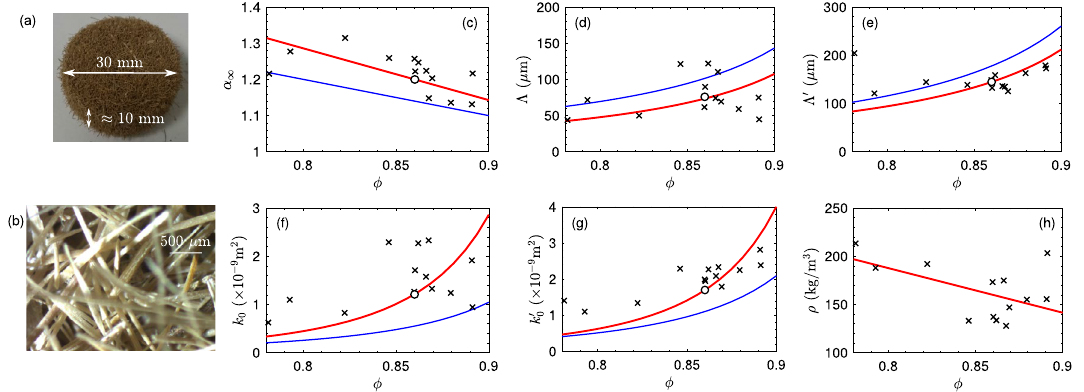
Figure 2. A picture of a sample is presented on ( a ), while a stereo microscopic image of the Aegagropilae fiber network is shown on ( b ). The tortuosity α ∞ ( c ), viscous (cid:31) ( d ) and thermal (cid:31) ′ ( e ) characteristic lengths and viscous k 0 ( f ) and thermal k ′ 0 ( g ) permitivities are shown in function of the porosity φ of the Aegagropilae fiber network. The markers are the experimentally recovered parameters, the dependency of each parameters are depicted in blue curves for the periodically aligned fiber model and in red curves for the homothetic transformation one. Open circles refer to the parameters that are used for the sonic crystal simulations. The density as a function of φ is depicted on ( h ) together with the linear plex and frequency dependent density and bulk modulus. They are described by the porosity φ , the tortuosity, α ∞ which provides information on the fiber entanglement, the viscous and thermal characteristic lengths (cid:31) and (cid:31) ′ which provide averaged values of respectively the minimum and maximal distances bewteen the fibers within the network, and viscous and thermal permeabilities k 0 and k ′ 0 . Figure 2c–g depicts the reconstructed parameters in function of the reconstructed porosity φ for the 13 samples. The measured density as a function of φ is also depicted in Fig. 2h and is found in good correlation with the porosity. As a first approximation, the samples were assumed to be constituted of infinitely long fibers perpendicular to the sample height and arranged on a square lattice. Under this assumption, analytic formulae of the 5 param- eters q = < α ∞ , � , � ′ , k 0 , k ′ 0 > are provided for φ > 0.6 in Ref. 25 . These expressions depend on the fiber radius a and porosity φ which equals 1 − π a 2 / l 2 , where l is the lattice size of the fiber arrangement. Minimizing in the least square sense the difference between the measured parameters q meas and q ( a , l ) provides l ≈ 130 µ m and a = 29 µ m which are qualitatively in accordance with the stereo microsopic (Olympus SZ61) image of the fibers shown in Fig. 2b. The corresponding results are plotted (blue curves) in Fig. 2c–g. Nonetheless, it is clear, notably from Fig. 2c, that the acoustic parameters of the Aegagropilae fiber network do not follow this simple model thus implying a more complex arrangement of the fibers. Therefore, we propose another model, based on the homothetic transformation assuming the solid volume over the Representative Elementary Volume (REV) of volume V is constant. Introducing a compression/dila- tion rate η = V i / V = ( 1 − φ)/( 1 − φ i ) from an initial state, indicated by the exponent i , to another one and referring to Ref. 26 , the tortuosity reads as α ∞ = 1 − η( 1 − α i ∞ ) . Referring to the definition of the thermal char- acteristic length, which is a purely geometric parameter and assuming that the pore surface is constant over the transformation, � ′ = φ/(φ i η)� ′ i . A similar trend is inferred for the viscous characteristic length thus providing � = φ/(φ i η)� i . As far as it concerns the viscous permeability, Carman-Kozeny 27 proposes k 0 = ζ a 2 φ/α ∞ , H where ζ is a shape factor assumed constant during the transformation and a H is the hydraulic radius which correspond to (cid:31) ′ . Therefore, we propose k 0 = (� ′ /� ′ i ) 2 φα i ∞ /(φ i α ∞ ) k i 0 and a similar trend is inferred for the thermal permeability thus providing k ′ 0 = (� ′ /� ′ i ) 2 φα i ∞ /(φ i α ∞ ) k ′ i 0 . Again, minimizing in the least square sense the difference between the measured parameters q meas and q (φ i , α i ∞ , � i , � ′ i , k i 0 , k ′ i 0 ) provides the follow- ing parameters of the initial state: φ i = 0.84 , α i ∞ = 1.23 , � i = 63 µ m , � ′ i = 124 µ m , k i 0 = 8.52 × 10 − 9 m 2 , and k ′ i 0 = 12 × 10 − 9 m 2 . The corresponding results are plotted (red curves) in Fig. 2c–g and are found in better agreement than those obtained assuming a periodically aligned arrangement of fibers. In particular, the tortuosity value is now in much better agreement, thus implying a complex entanglement of the fiber during the formation of the Aegagropilae fiber network. The most often encountered porosity is 0.86. Therefore, the acoustic simula- tions of the fully natural 3-dimensional (and of the 2-dimensional man modified) sonic crystal were performed with the acoustic parameters reported on Table 1 and marked by a circle in Fig. 2c–g . These values are quite in accordance with usual values encountered for manufactured fibrous materials such as mineral wool, accounting for the fact that the Aegagropilae fiber diameter is much larger. These results apply several comments. The pore constrictions are around � ≈ 60 µ m , while the pore radius � ′ ≈ 120 µ m , which is again consistent with the stereo microscopic image of the fibers Fig. 2b. The ratio between these two lengths is around 2 which is consistent with usual fibrous materials. The fiber arrangement is complex as testified by the large value of the tortuosity. Although the number of samples is not sufficient to develop a probability density function, acoustic characterization seems to be a simple and efficient tool to assess the micro- structure of Aegagropilae fiber network.